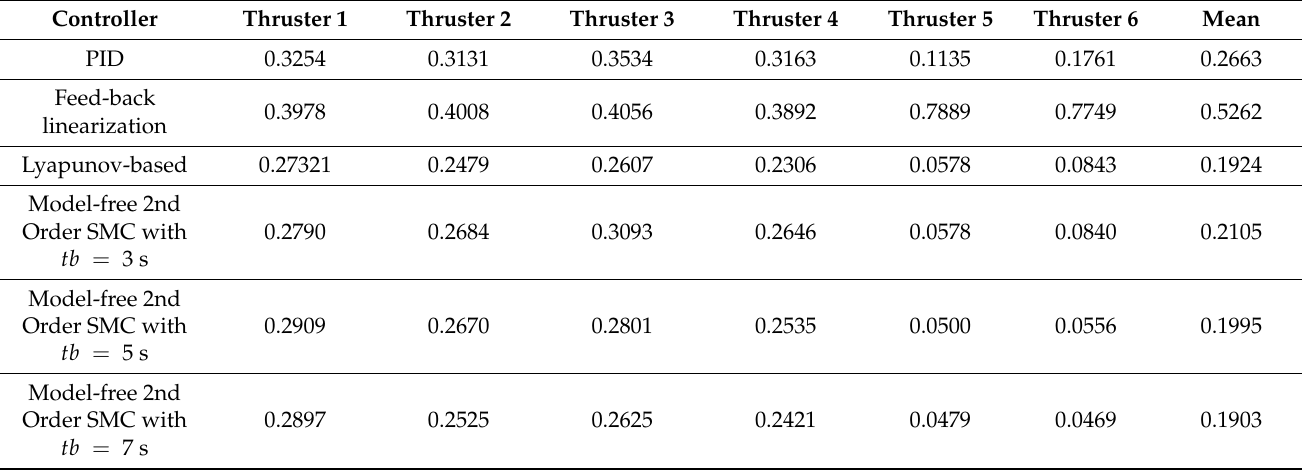
Table 6. RMS values for thrusters control coefficients when the vehicle is subject to high ocean